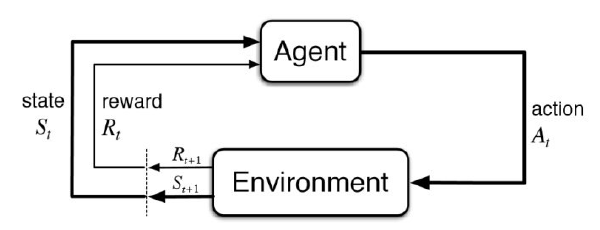
Figure 15. Overview of the Reinforcement Learning approach based on